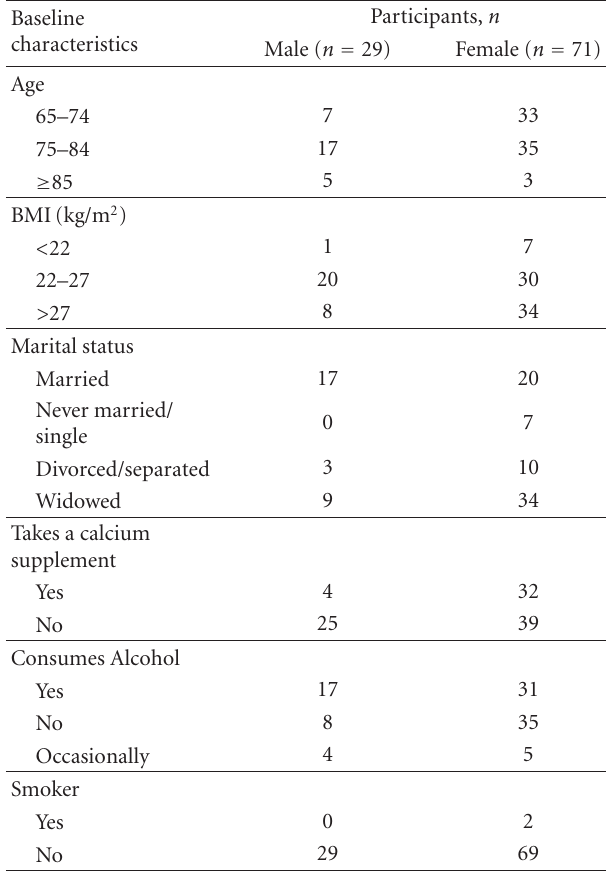
Table 1: Baseline characteristics of study